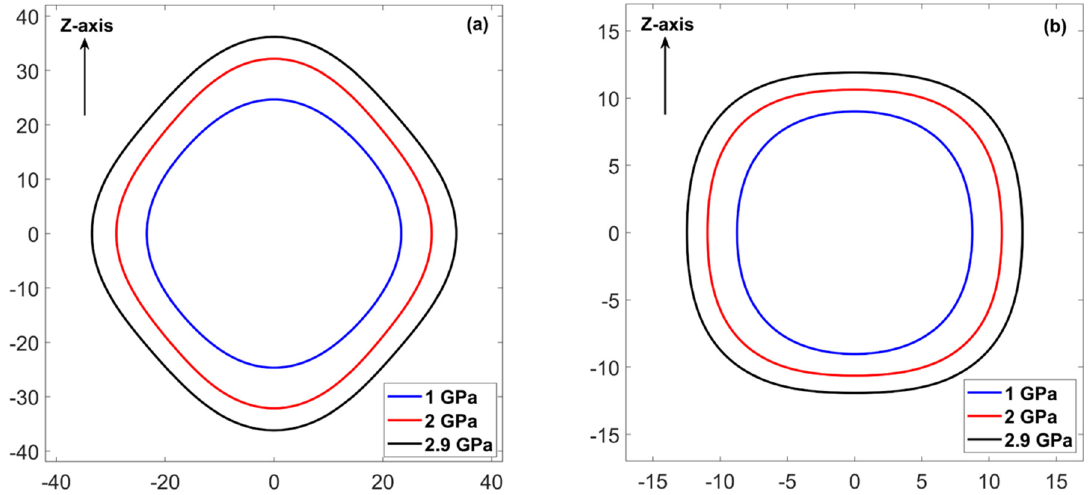
Figure 11. Polar plots of Young’s E ( a ) and shear G ( b ) moduli of Xe-NH sH gas hydrate at different pressures and 0 K. Moduli unit is GPa.